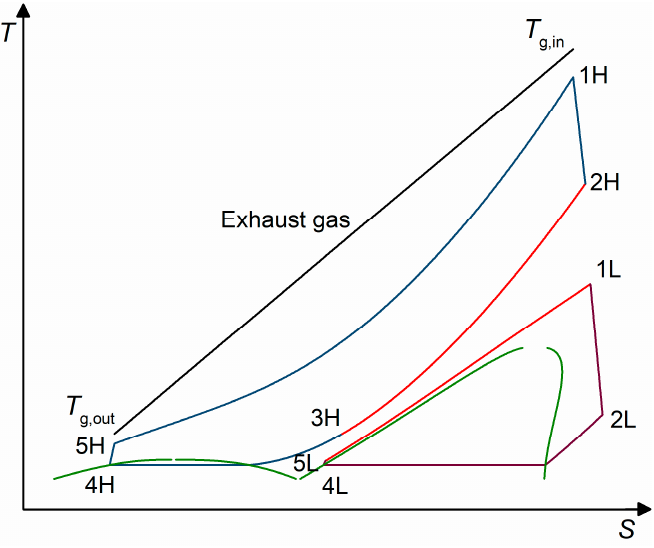
Figure 5. T-s diagram of CO 2 -TC / OTC combined system.